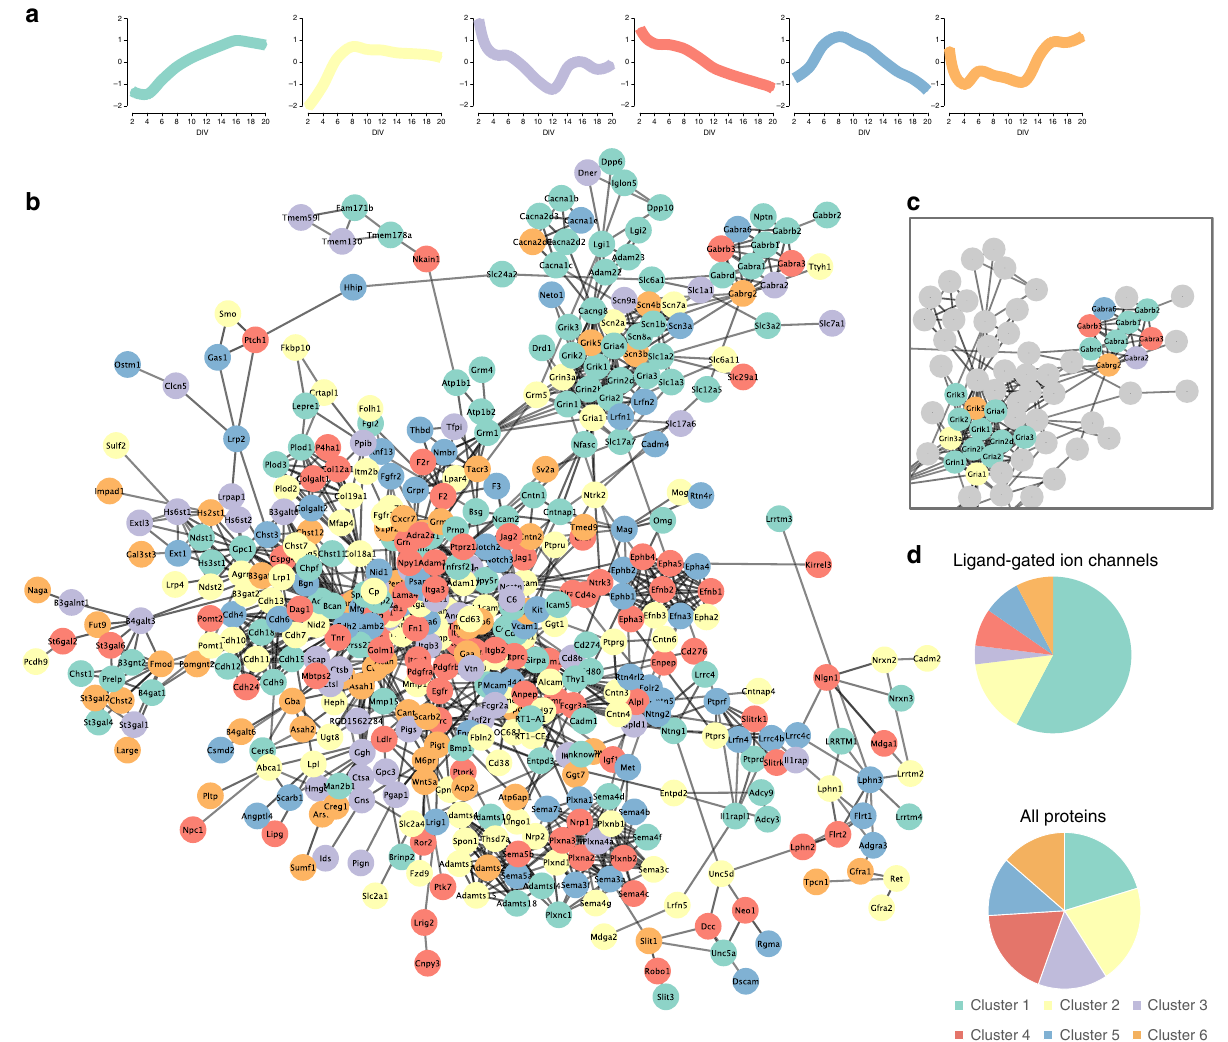
Fig. 3 The neuronal surfaceome interaction network. a Cluster legend showing median cluster pro fi le with the color code used in the string network b String network representation of the largest connected cluster of identi fi ed surface proteins; edges represent string con fi dence of 0.7 93 . c Network representation of ligand-gated ion channels is shown on the top right. d Pie charts of cluster contributions to ligand-gated ion channels and all surfaceome proteins. Source data are provided as a Source Data fi